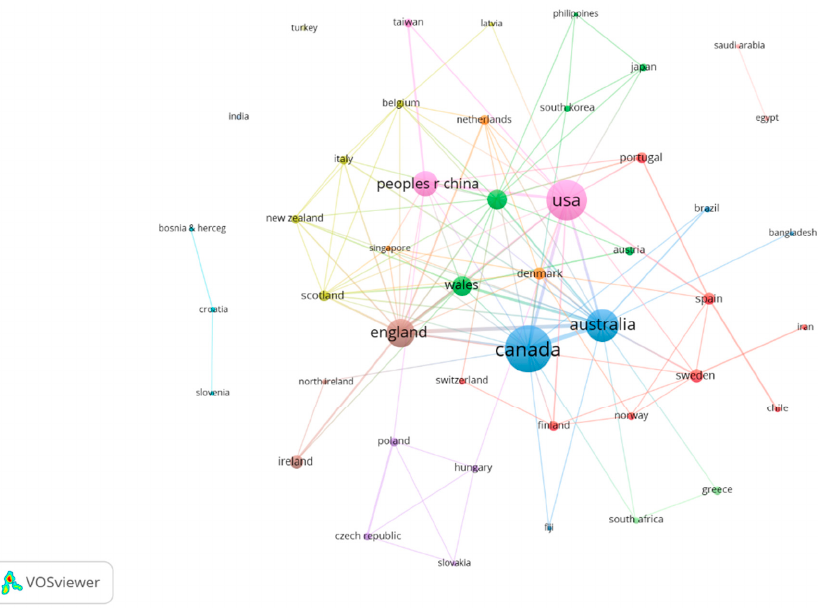
Figure 2. Country/region co-authors graph on physical literacy.